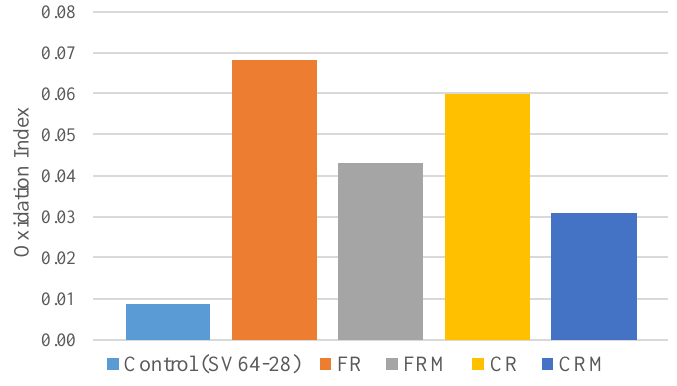
Figure 9. FTIR carbonyl oxidation indices.